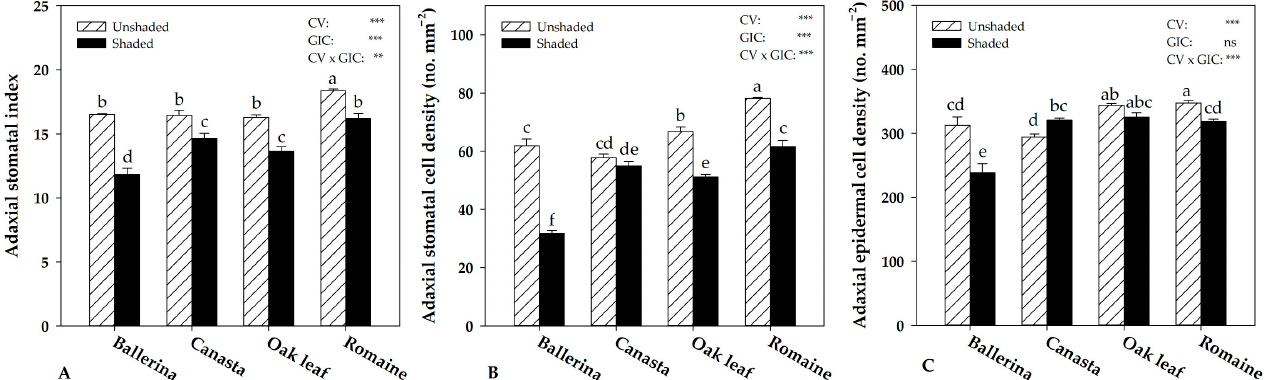
Figure 4. Effect of Cultivar (CV) and Greenhouse Irradiance Conditions (GIC) on morpho-anatomical traits of adaxial side of Lactuca sativa L. Stomatal index ( A ), stomatal cell density ( B ), and epidermal cell density ( C ). Data are mean values ± standard error, n = 3. Mean comparisons were performed by Duncan’s Multiple Range Test (DMRT) for CV and by t-Test for GIC. Different letters within columns indicate significant mean differences compared by DMRT ( p = 0.05). ns, **, and *** denote nonsignificant or significant effects at p ≤ 0.01 and 0.001, respectively.